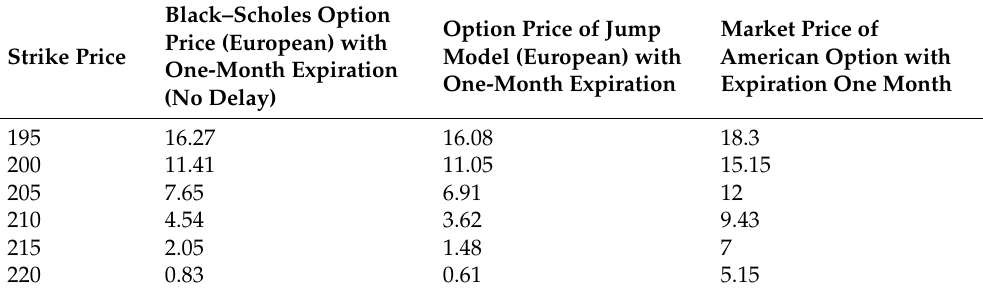
Table 1. Call option price comparison for T = 1 month for Microsoft stock.